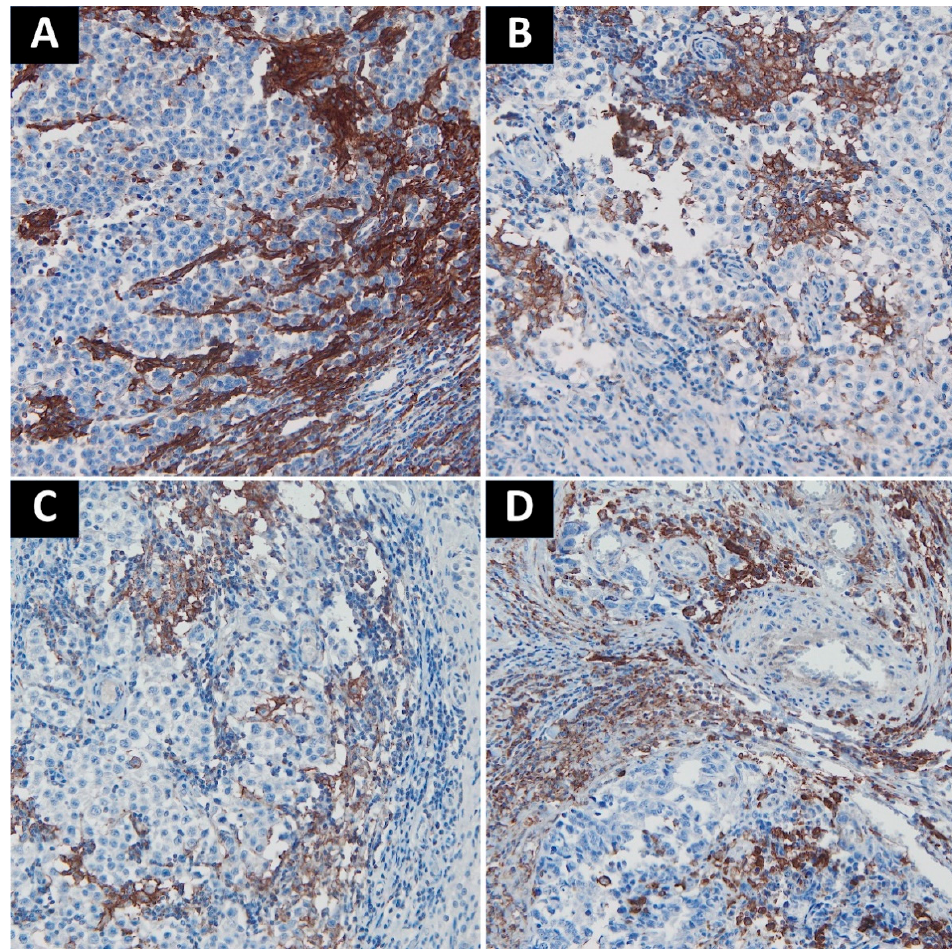
Figure 2. Representative examples of PD-L1 staining. ( A ). Intense staining in TAICs along the interface between fibrovascular septa and tumor cells; ( B ). Moderately positive to negative TAICs in seminoma; ( C ). Weakly positive to negative TAICs in seminoma; ( D ). Embryonal carcinoma with moderate PD-L1 staining in TAICs. Abbreviations: PD-L1: programmed death-ligand 1; TAICs: tumor-associated immune cells.